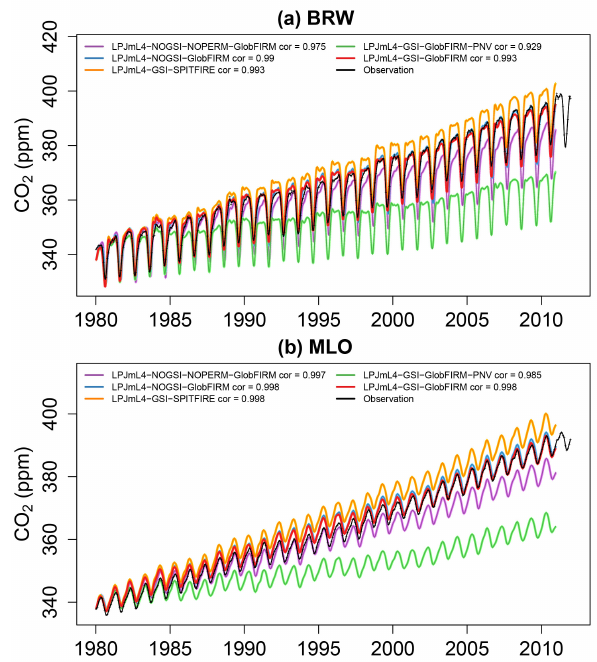
Figure 1. Comparison of the atmospheric CO 2 concentrations at Point Barrow (BRW; panel a ) and Mauna Loa (MLO; panel b ) for the different LPJmL4